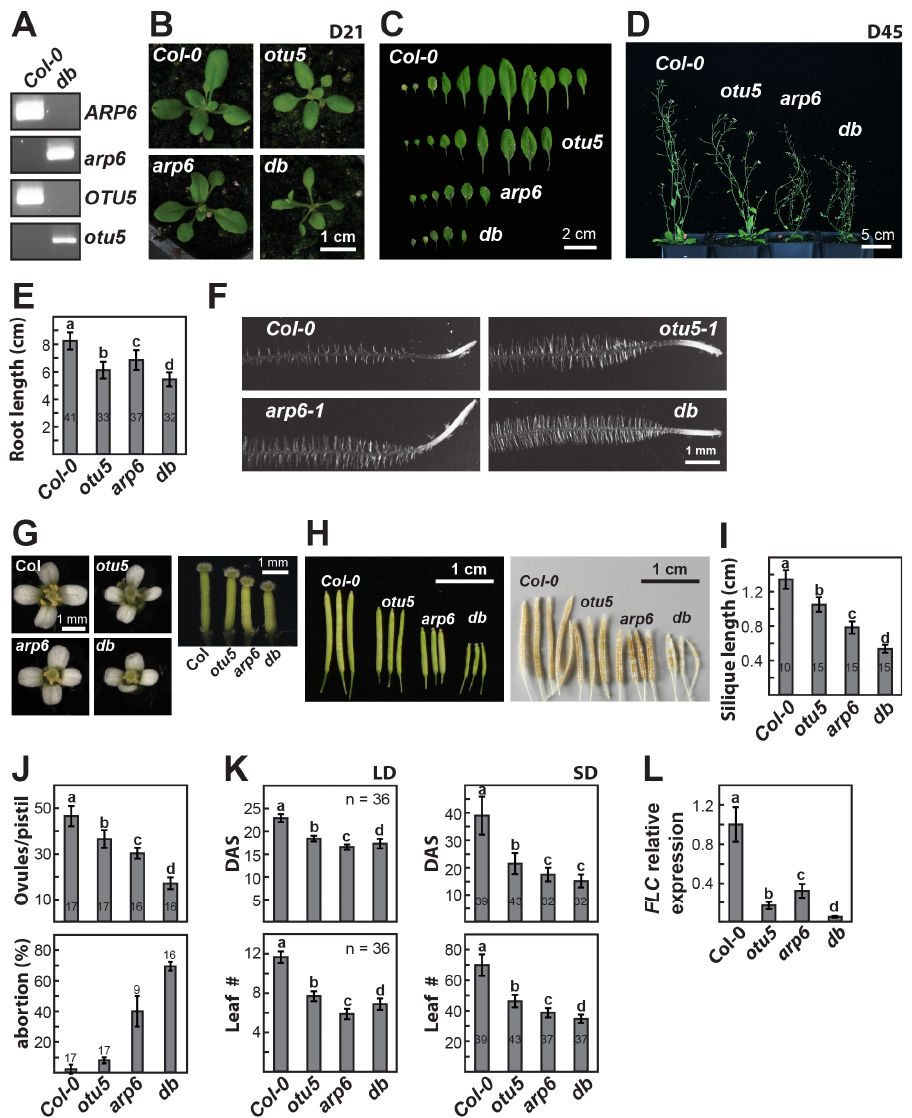
Figure 9. Homozygous otu5 arp6 plants display synergistic phenotypes. ( A ) Genotyping of arp6 otu5 plants by genomic DNA PCR. The presence of arp6-1 ( arp6 ) and otu5-1 ( otu5 ) T-DNA junctions was detected in the otu5 arp6 double mutant ( db ), and the wild-type ARP6 and OTU5 fragments were only detected with Col-0. ( B ) Representative 21 DAS plants grown under long-day conditions. ( C ) Representative sets of rosette leaves at 27 DAS in order of production. ( D ) Representative 45 DAS plants grown under long-day conditions. ( E ) Average primary root lengths of seedlings at 12 DAS grown under long-day conditions ( n = 32–41). ( F ) Representative root tips of seedlings at seven DAS grown under phosphate-replete conditions. ( G ) Representative flowers (top views, left four panels) and gynoecia/pistils (right). ( H ) Representative mature fresh-harvested (left) or alcohol-bleached siliques (right). ( I ) Averaged lengths of matured siliques. The numbers of siliques averaged are indicated. ( J ) Averaged ovule number of each silique (top) and ovule abortion rate (bottom). The numbers of siliques averaged are indicated. ( K ) Flowering times measured either by DAS (top panels) or rosette leaf number (bottom panels, Leaf #) at bolting of plants grown under long-day (LD) or short-day (SD) conditions. ( L ) Relative FLC expression levels examined by RT-qPCR in otu5-1 , arp6-1 , and otu5 arp6 ( db ) plants compared with Col-0. The averaged relative FLC expression levels were determined from three biological repeats. Different letters denote significant differences by pairwise comparison using Student’s t -test; error bars indicate standard deviations.